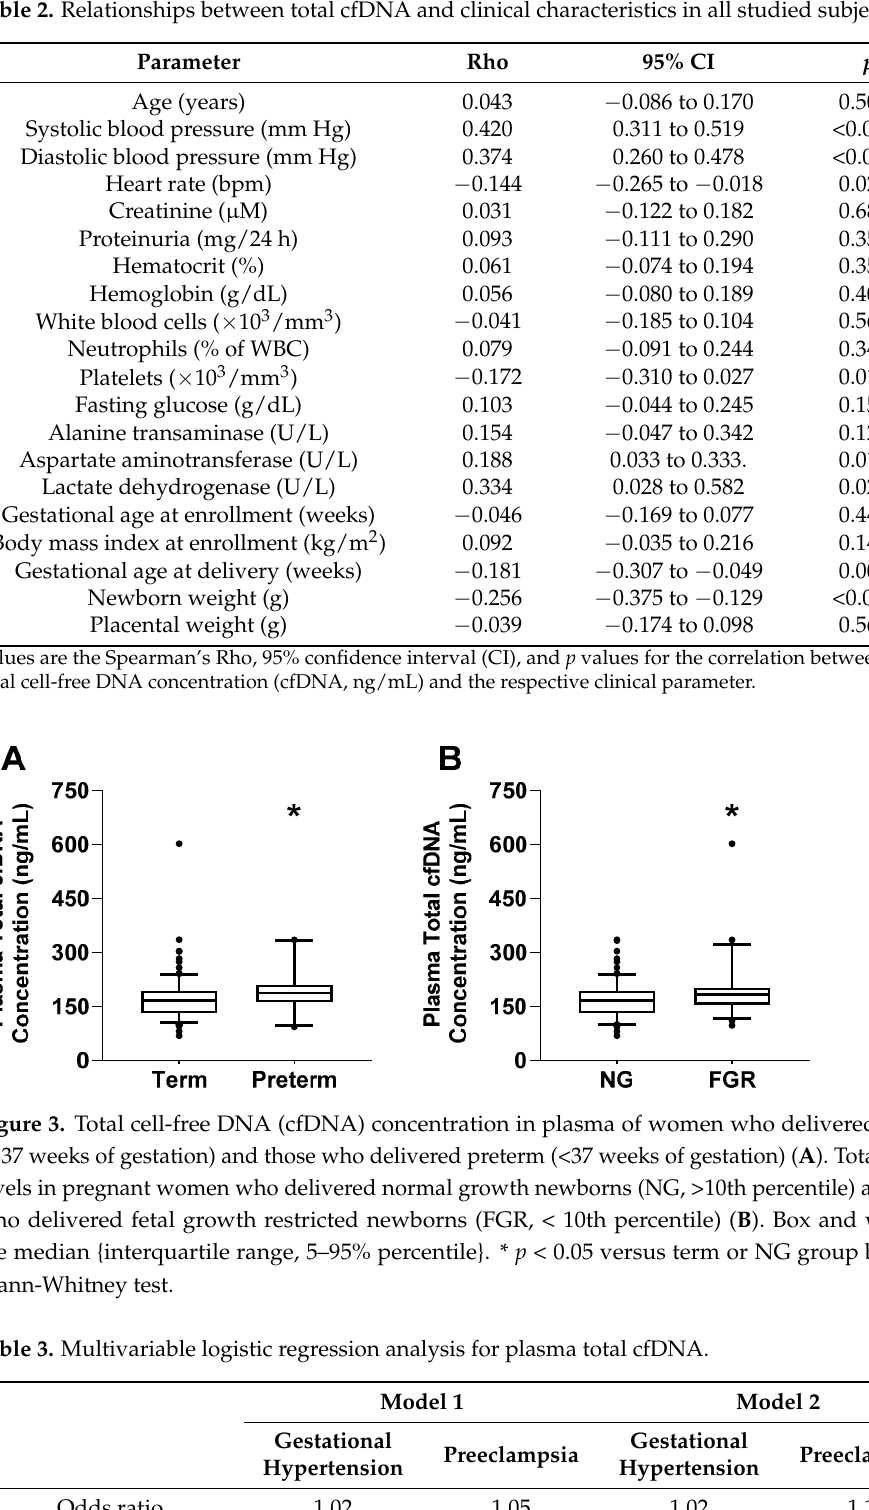
Table 2. Relationships between total cfDNA and clinical characteristics in all studied subjects.